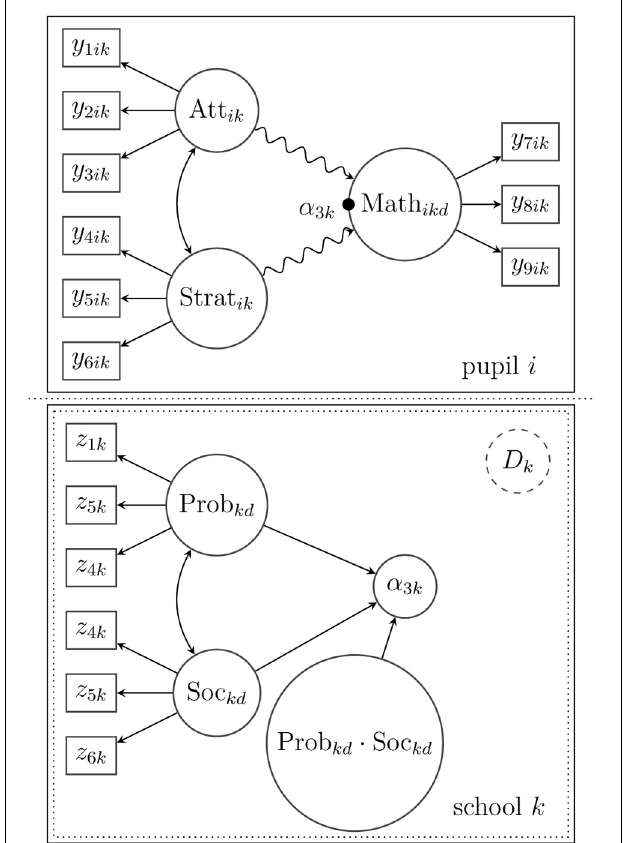
FIGURE 6 | Structural models and measurement models on the within-level (Level 1) and between-level (Level 2). On Level 1, the math skill (Math) of a pupil i is predicted by his/her general attitude toward reading (Att) and his/her experienced teaching strategies (Strat). The snake-type arrows indicate a flexible spline approximation of the latent variable relationship. On Level 2, the average math skills of pupils (latent intercept α 3 k ) in school k are explained by a nonlinear interaction between structural problems in the school (Prob) and the school’s social environment (Soc). The non-normality of the latent predictors is approximated by a mixture